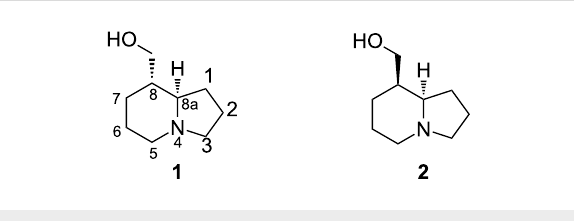
Figure 1: Structures of (±)-tashiromine ( 1 ) and (±)-epitashiromine ( 2 ) showing the systematic numbering of the indolizidine skeleton.